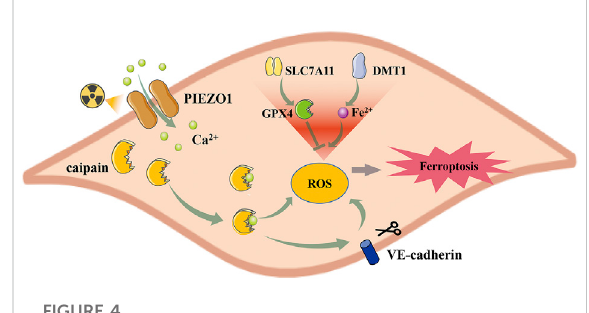
FIGURE 4 PIEZO1 regulates radiation-induced ferroptosis in lung endothelial cells. Radiation increased the expression of PIEZO1 in the lung endothelial cells, which caused the in fl ux of Ca 2+ . Increased intracellular Ca 2+ activates caipain and promotes ferroptosis by regulating SLC7A11, GPX4, and DMT1 expression. Besides, the Ca2+/Caipain pathway can also promote the degradation of VE-cadherin, leading to ferroptosis. PIEZ O 1, Piezo-typemechanosensitiveionchannelcomponent1;SLC7A11, Cystine/glutamate antiporter solute carrier family seven